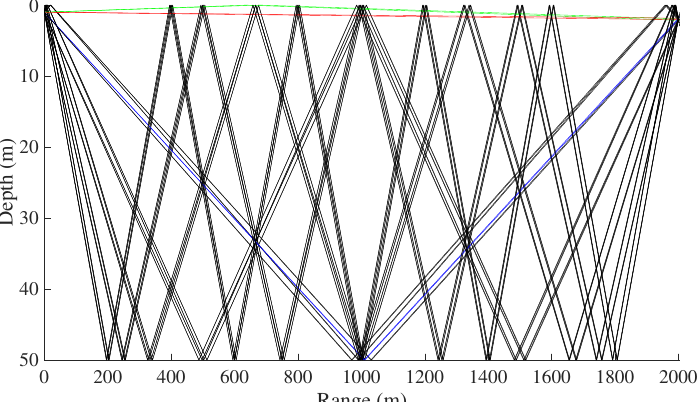
Figure 6. Eigenray trace of sound propagation during simulation with the Bellhop toolkit. The rays are plotted using different colors depending on whether the ray hits one or both boundaries, red for direct, green for the surface, blue for the bottom, and black for both. The multi-path effect is clearly shown above.